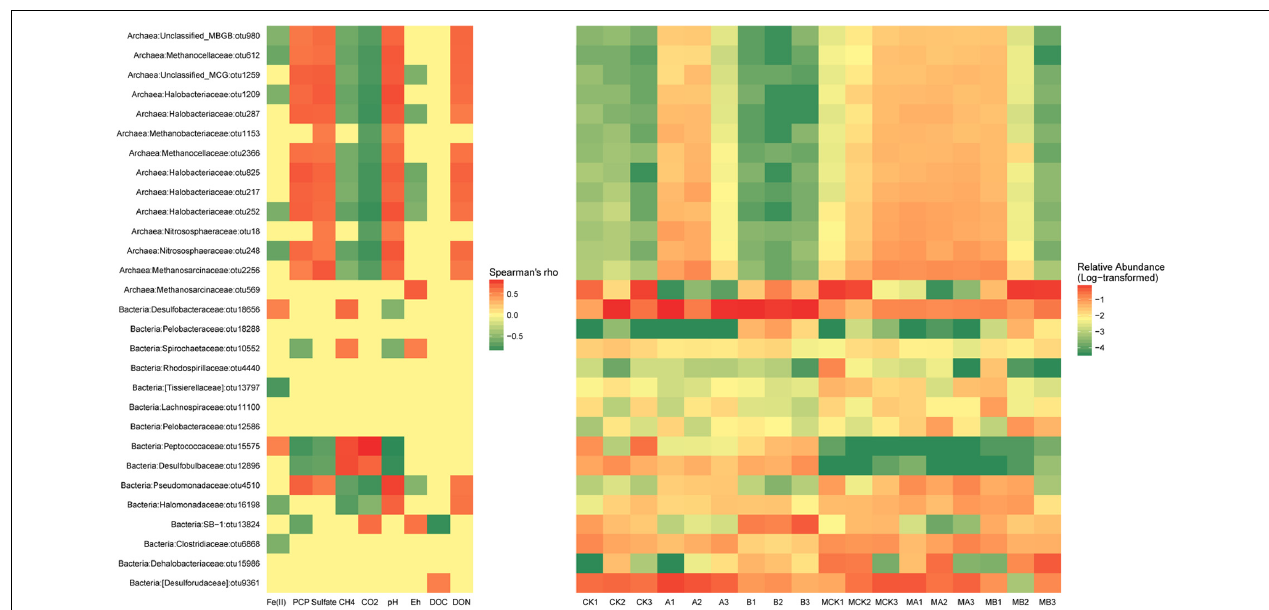
FIGURE 4 | The significant correlations ( p -value < 0.05) between environmental factors and relative abundance of the dominant bacterial and archaeal OTUs (Left) and the relative abundance of these OTUs in different treatments